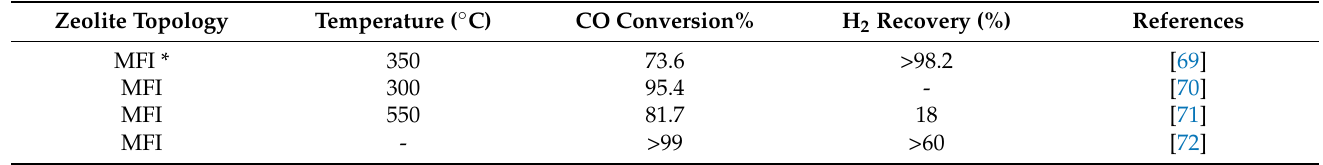
Table 1. Performance of zeolite membrane reactors in the WGS process.